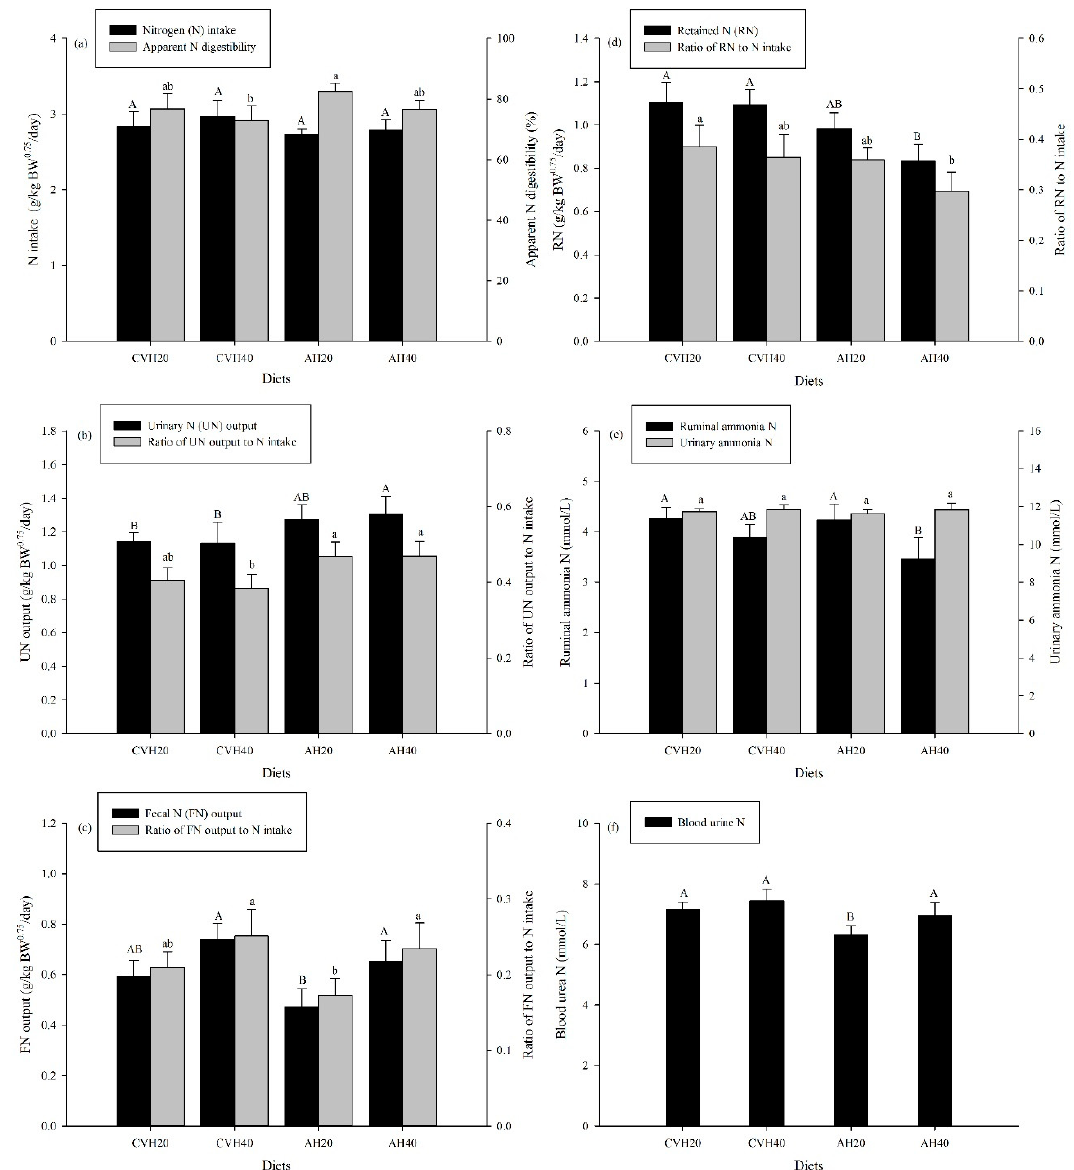
Figure 4. Nitrogen balance and utilization efficiency of cattle among the four diet groups. Values are presented as the mean ± standard deviation (SD). Uppercase letters represent the differences among the four diet groups in nitrogen balance and lowercase letters represent the differences among the four diet groups in nitrogen utilization. ( a ) represents N intake and apparent N digestibility ; ( b – d ) represent UN output, FN output, and RN, respectively, as well as their proportion of N intake; ( e ) represents ruminal ammonia N and urinary ammonia N concentrations; ( f ) represents blood urea N.